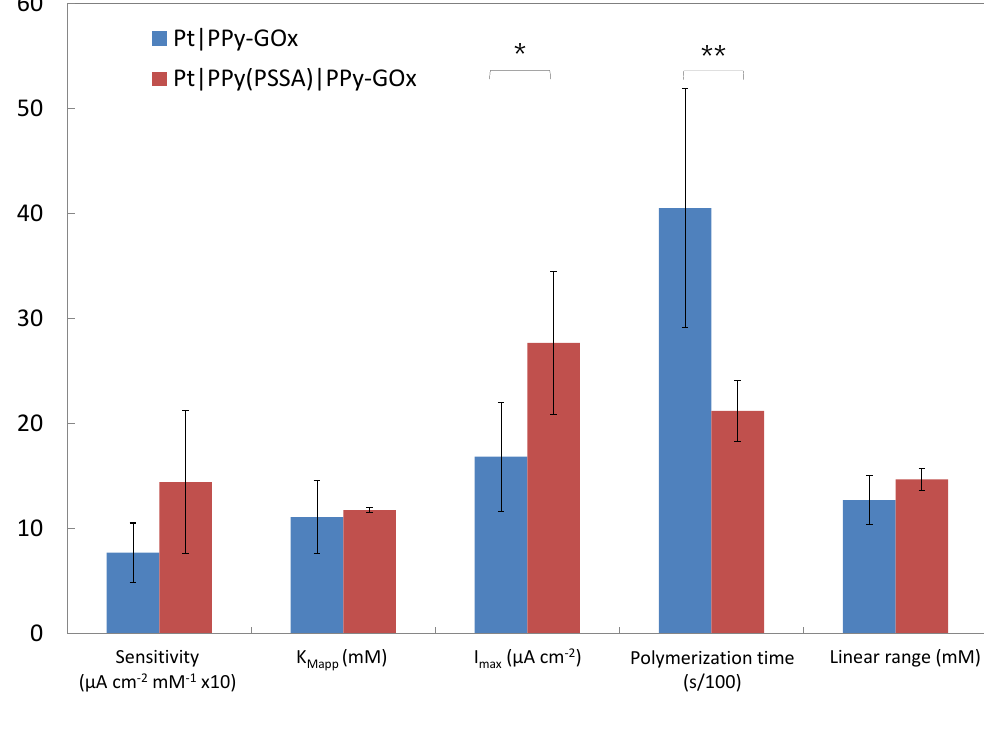
Figure 1. The effects of the PPy-PSSA seeding layer of 10 mC/cm 2 on the enzyme kinetic parameters of biotransducers fabricated using 100 mC/cm 2 (error bars show 95% confidence intervals, n ≥ 5). * = p < 0.05; ** = p <